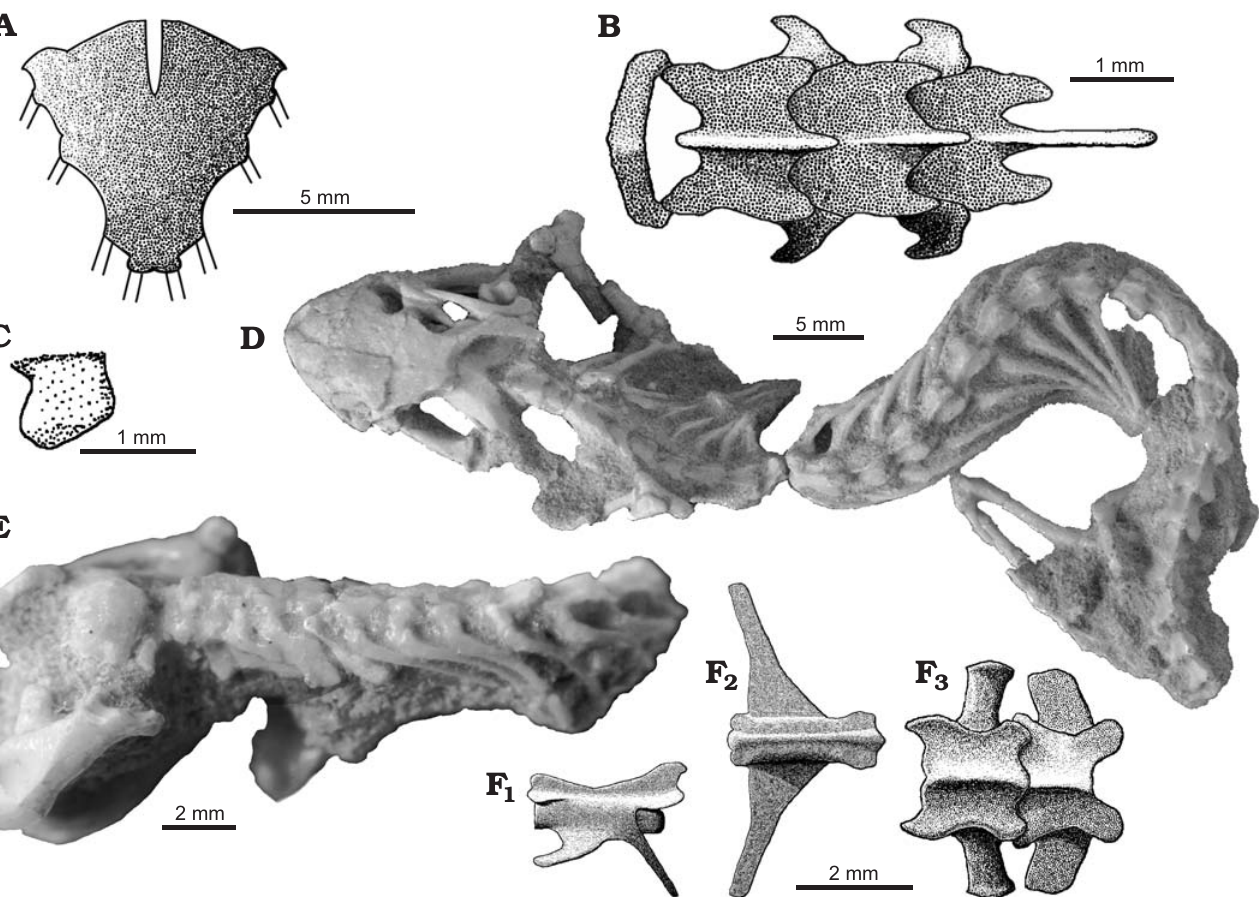
Fig. 1. The axial skeleton of the stem-amphisbaenid Slavoia darevskii Sulimski, 1984 from late Campanian of Mongolia. A . The reconstruction of the first four vertebrae in dorsal view (based on different specimens). B . The reconstruction of sternum in ventral view (based on PIN 4487/14). C . The re- construction of first hypapophysis (based on ZPAL MgR-I/108). D . PIN 3142/358, complete presacral vertebrate column in dorsal view; photo courtesy of Vladimir Alifanov. E . ZPAL MgR-I/78, the neck with well preserved, blunt and broad cervical ribs. F . The reconstruction (based on ZPAL MgR-I/8) of the fifth caudal vertebra in lateral (F 1 ) and dorsal (F 2 ) views; sacral vertebrae in dorsal view (F 3